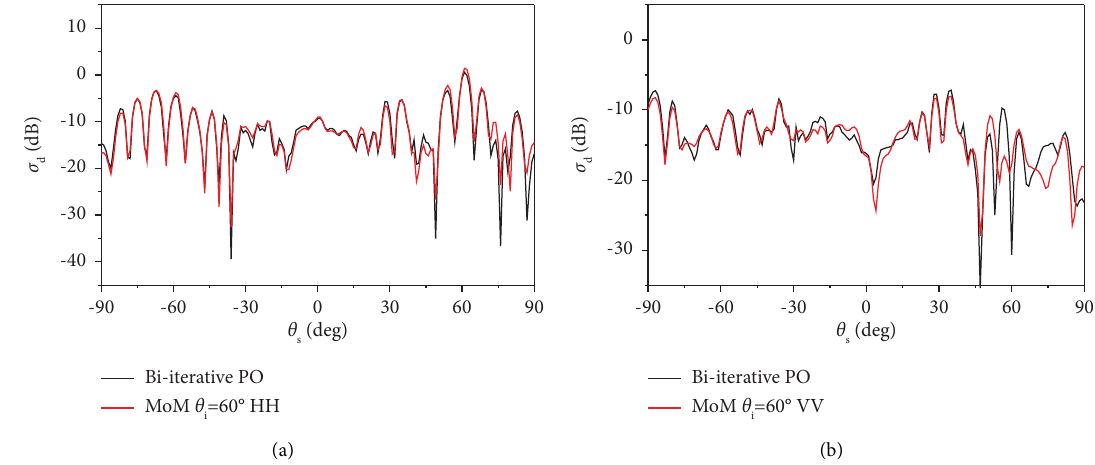
Figure 4: Te comparison of D-RCS from a cylinder above two-layered soil surfaces using the bi-iterative PO and MOM with (a) HH and (b) VV polarizations.